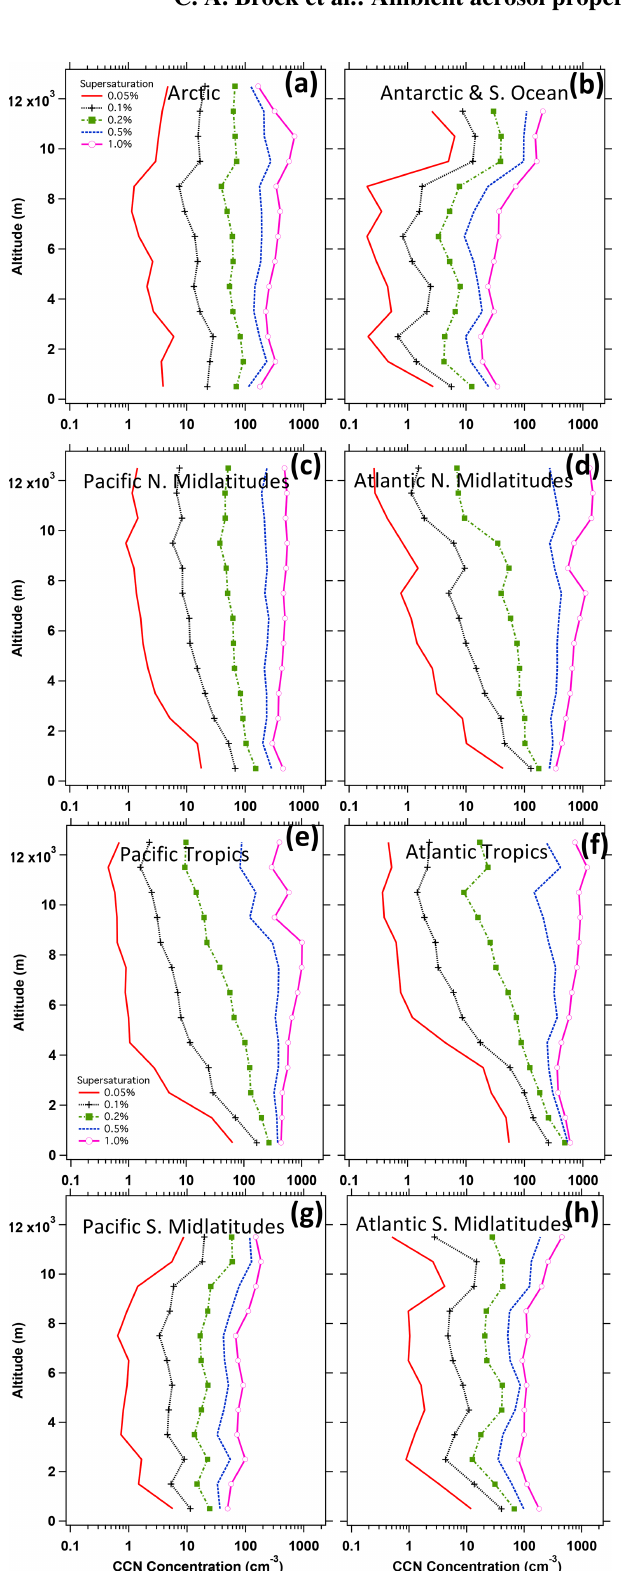
Figure 14. Median vertical profiles of calculated CCN concentration at STP for supersaturations of 0.05%, 0.1%, 0.2%, 0.5%, and 1% for different regions sampled during the entire ATom project. (a) Arctic. (b) Antarctic and Southern Ocean. (c) Pacific northern midlatitudes. (d) Atlantic northern midlatitudes. (e) Pacific tropics. (f) Atlantic tropics. (g) Pacific southern midlatitudes. (h) Atlantic southern midlatitudes.